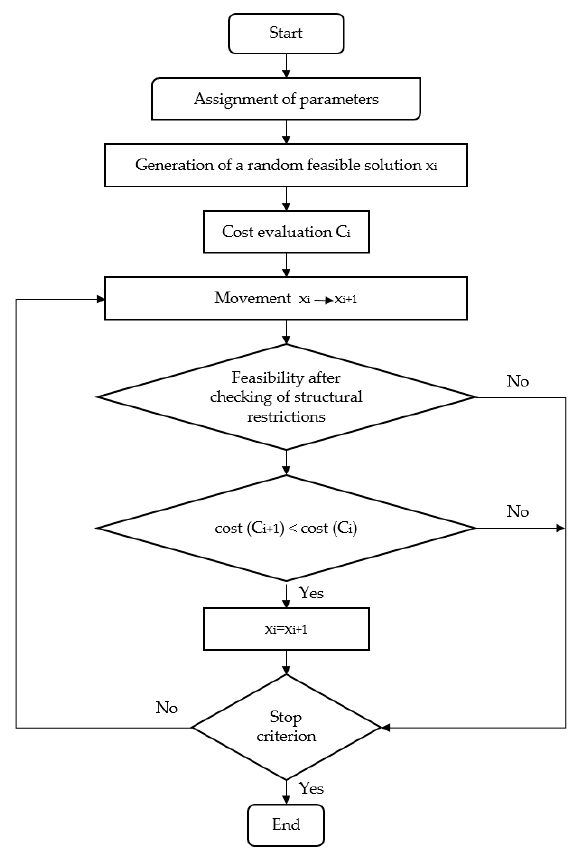
Figure 2. Flowchart of the descent local search (DLS) process.